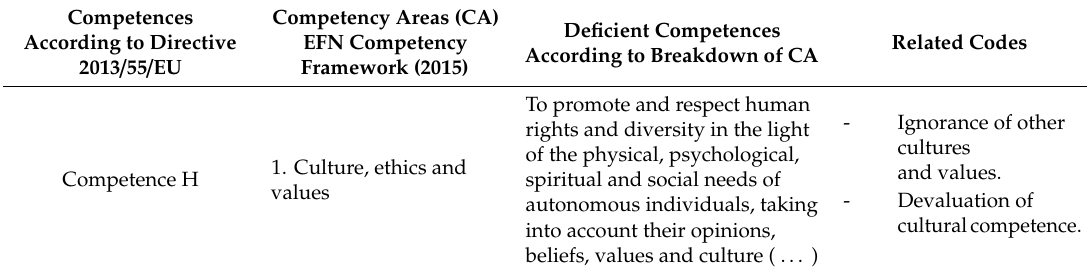
Table 5. Results: Deficient competences according to the classification by the European Federation of Nurses (EFN,